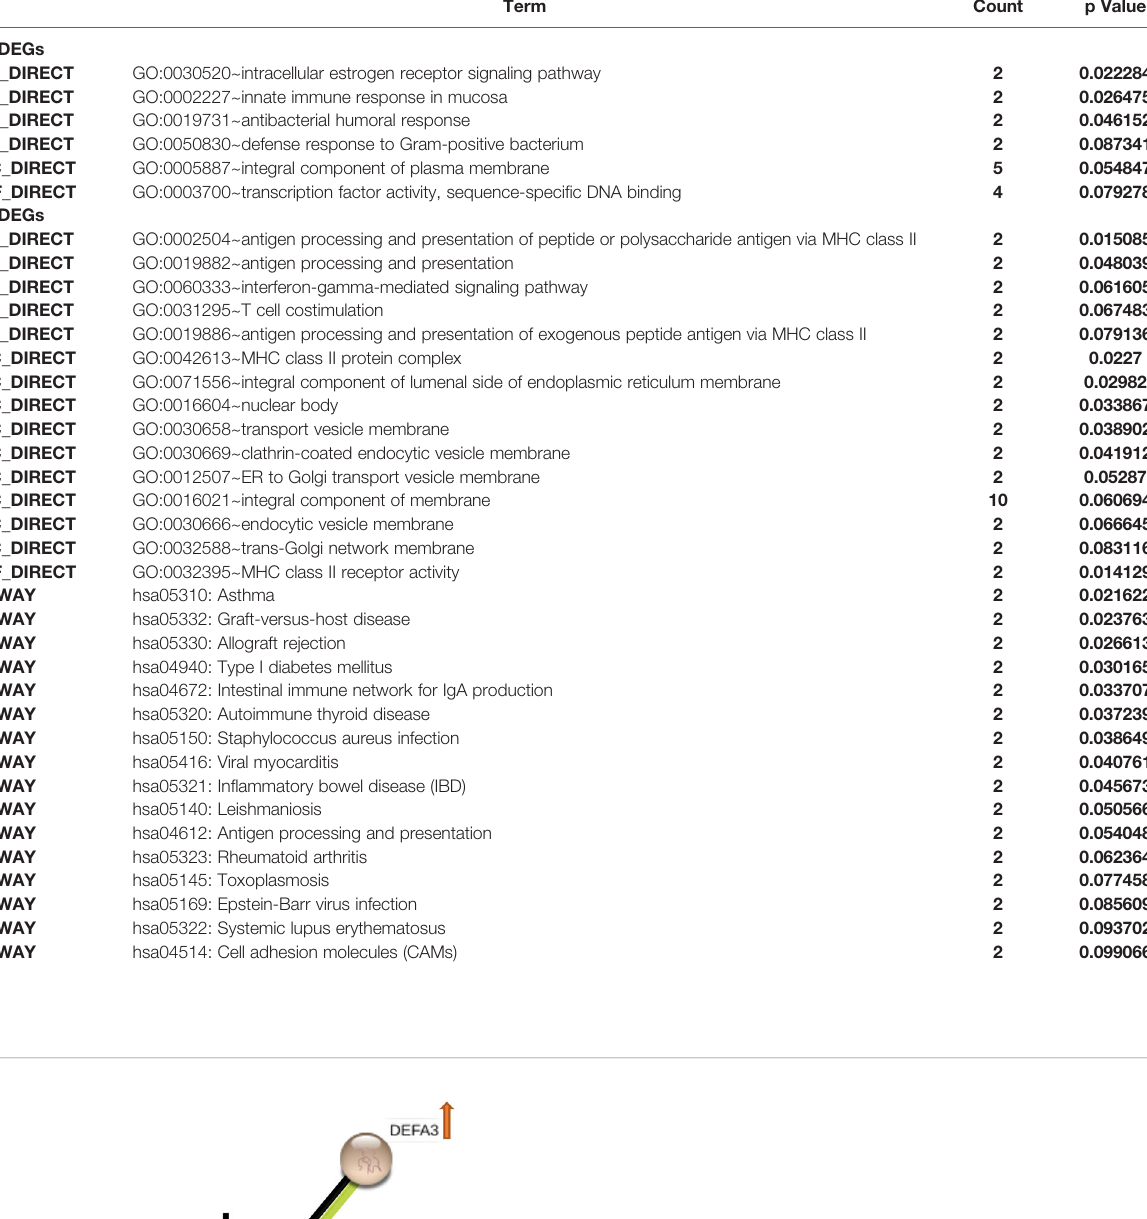
TABLE 2 | The GO and KEGG Enrichment Analysis of DEGs.